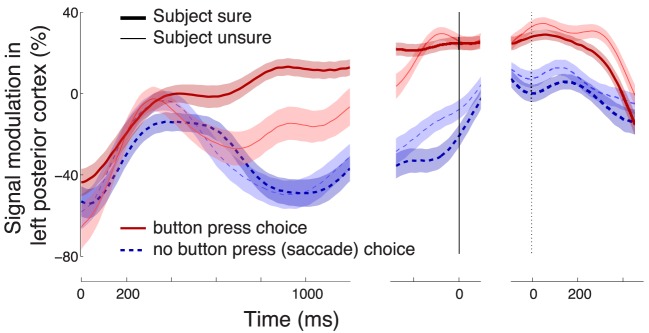
Effects following a trial elimination procedure. Elimination of trials in which EEG signals at any channel exceeded a particular threshold (Section 2) had only minimal impact on the confidence-related effect. Same format as in Figure 5B.